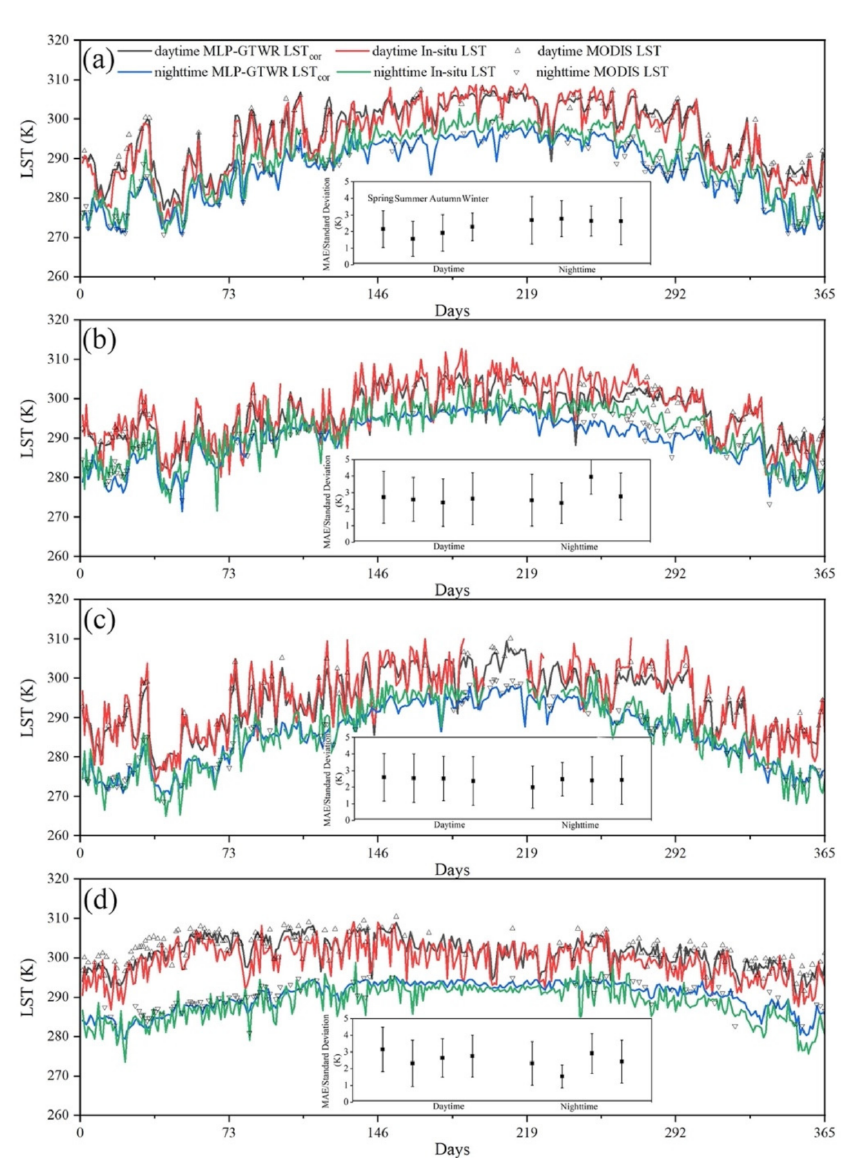
Figure 8. Temporal variations in daytime and nighttime MODIS LST, MLP-GTWR LST cor , and in situ measurements at four flux stations: Qianyanzhou ( a ), Dinghushan ( b ), Taoyuan ( c ), and Xishuang- banna ( d ). The subplots are seasonal statistics of MLP-GTWR LST cor against in situ measurements. The square dots give the MAE for daytime and nighttime, with the length of the line centered at each square dot representing one standard deviation of the